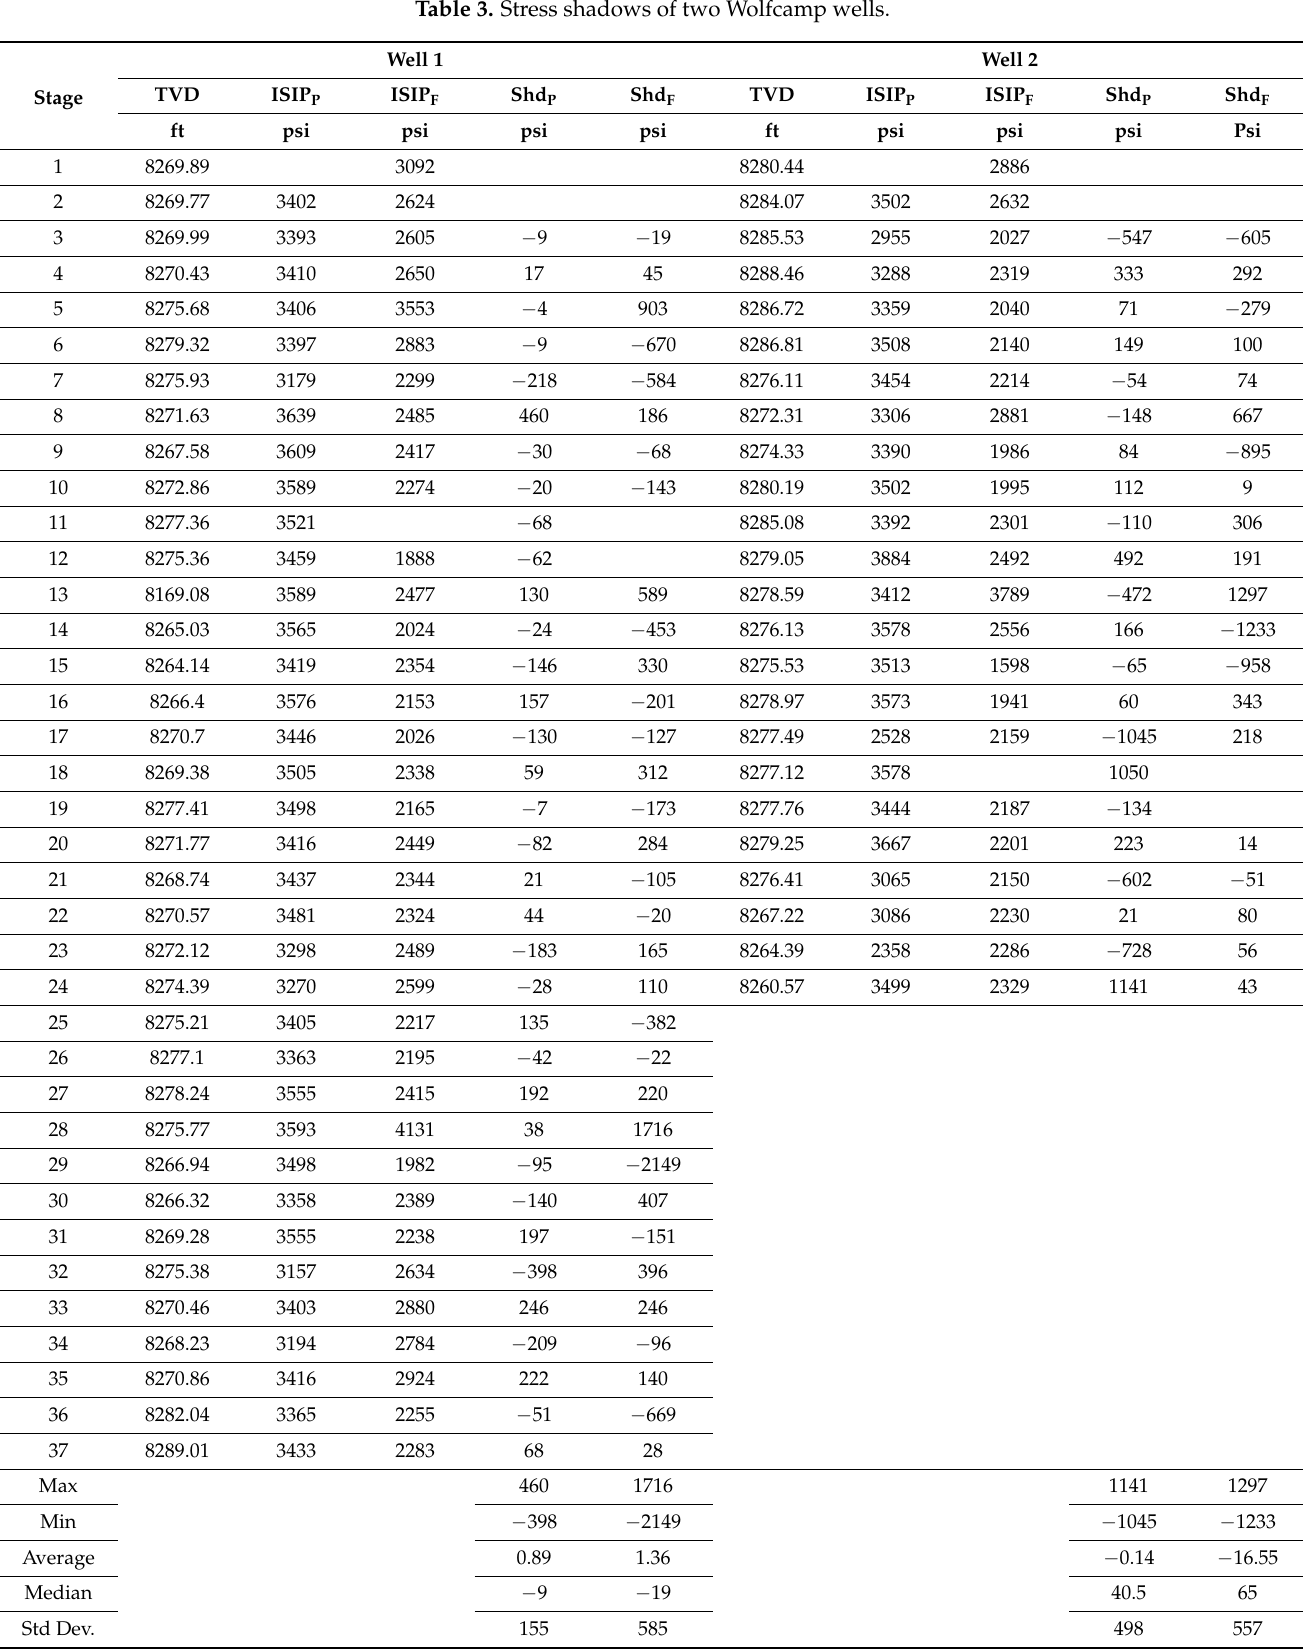
Table 3. Stress shadows of two Wolfcamp